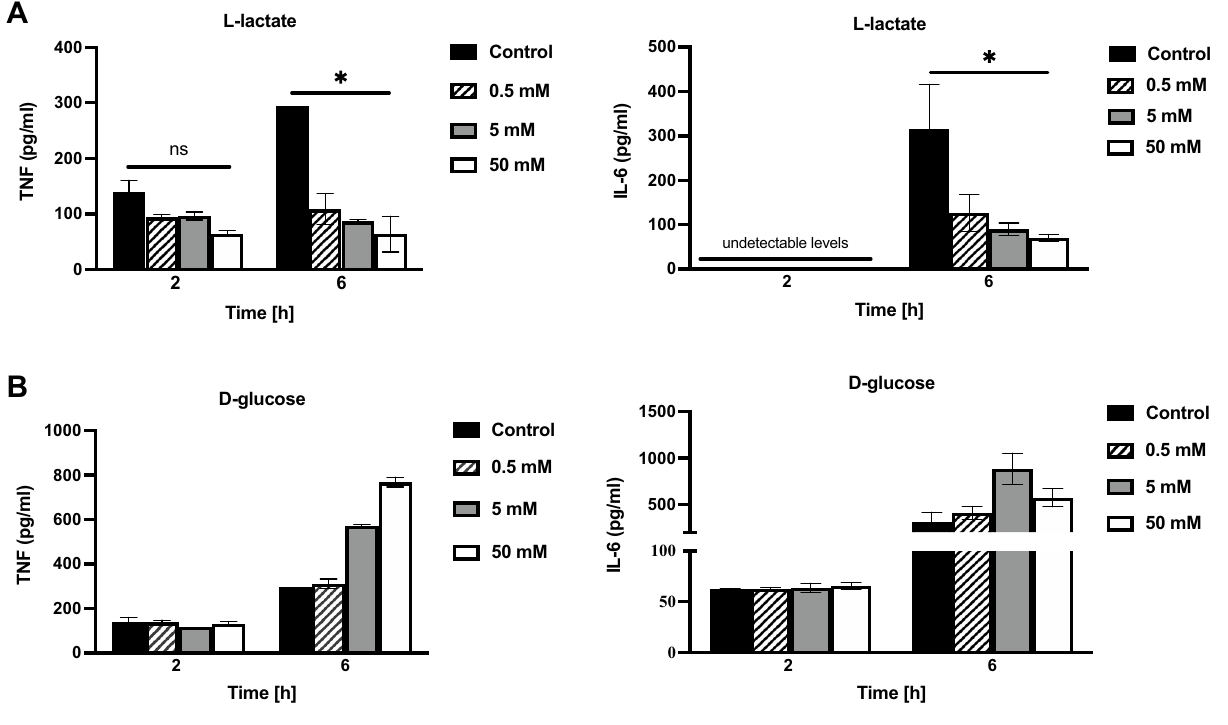
Figure 6. l-Lactate but not d-glucose reduces TNF and IL-6 production in macrophages. THP-1 cells were stimulated with H. pylori alone (control) or in combination with different concentrations of l-lactate ( A ) or d-glucose ( B ) for 2 and 6 h. The amounts of TNF and IL-6 in the cell-free supernatants were determined by ELISAs. Data represent the means and standard deviation of triplicate samples and are representative of two independent experiments. *P < 0.05 using ANOVA followed by a Bonferroni posttest.